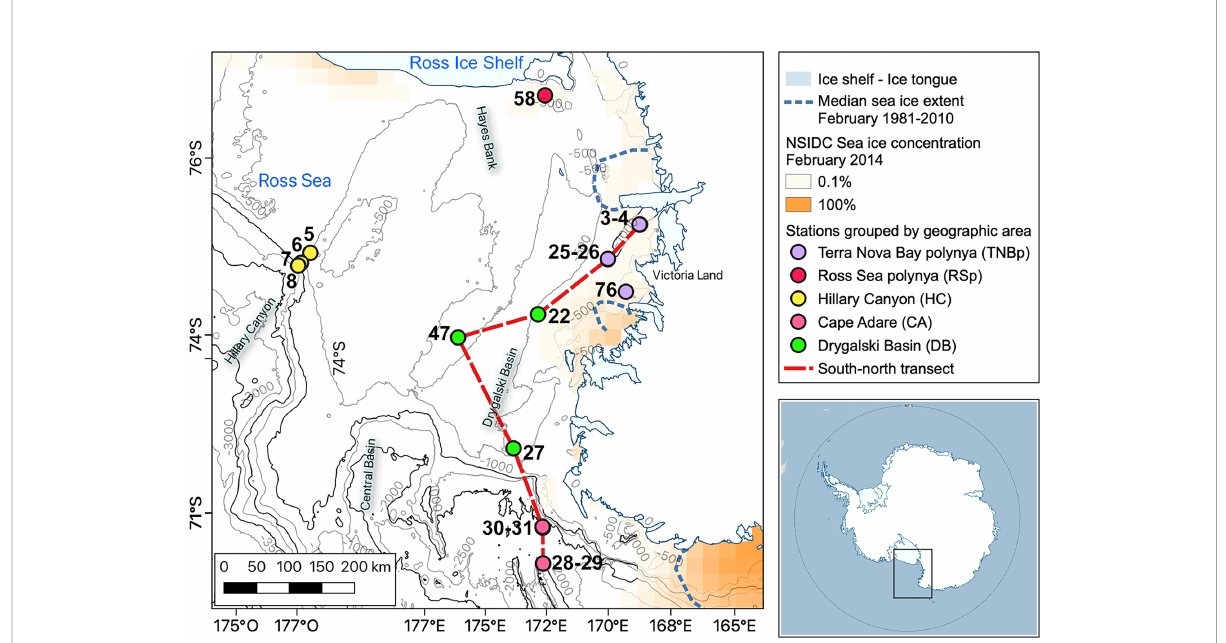
FIGURE 1 Map of the Ross Sea. Sampling stations during the XXIX Italian expedition are indicated by circles. The geographic areas in which the sampling stations are grouped are Terra Nova Bay polynya (TNBp), Ross Sea polynya (RSp), Hillary Canyon (HC), Cape Adare (CA), and Drygalski Basin (DB). Bathymetry is from Arndt et al. (2013) (IBCSO V1.0) with 500 m contour intervals (1,000, 2,000, and 3,000 m in dark lines). Polynya regions were shown using the satellite-derived sea-ice concentration during February 2014 (National Snow and Ice Data Center (NSIDC), Fetterer et al., 2017). Median extent of sea ice in February over a 20-year period (1981 – 2010) (dashed blue contours, Fetterer et al., 2017). Map developed from Quantarctica GIS package, Norwegian Polar Institute (Matsuoka et al.,